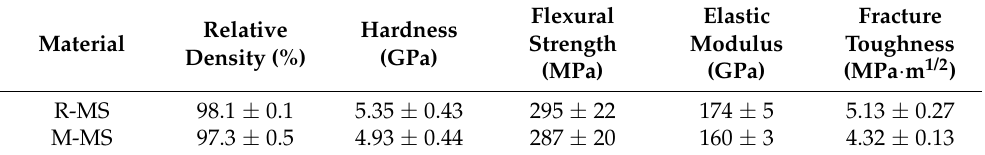
Table 2. Mechanical Properties of MCMB-SiC